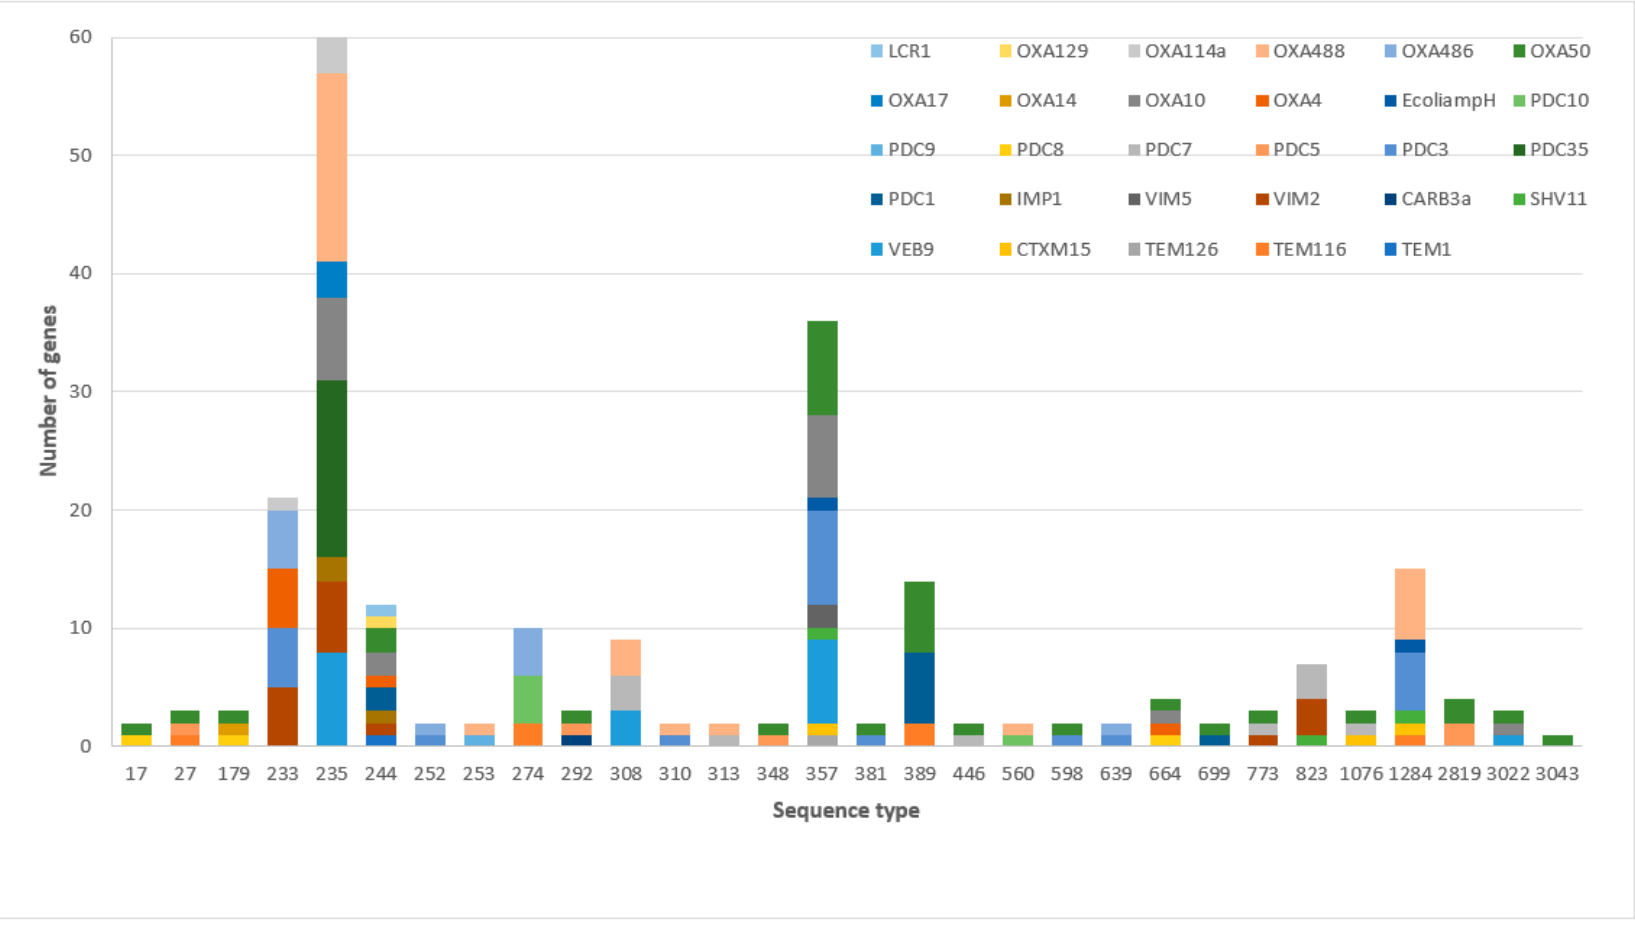
Figure 2. The distribution of β -lactamase genes was associated with different MDR- P. aeruginosa sequence types.3.3. The association of β -lactamase classes